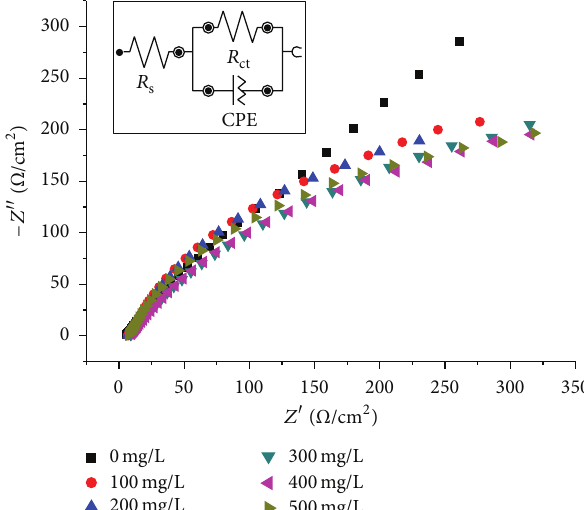
Figure 2: The representative Nyquist plots in the absence and pres- ence of different concentration of Myrmecodia Pendans inhibitor (insert:equivalent